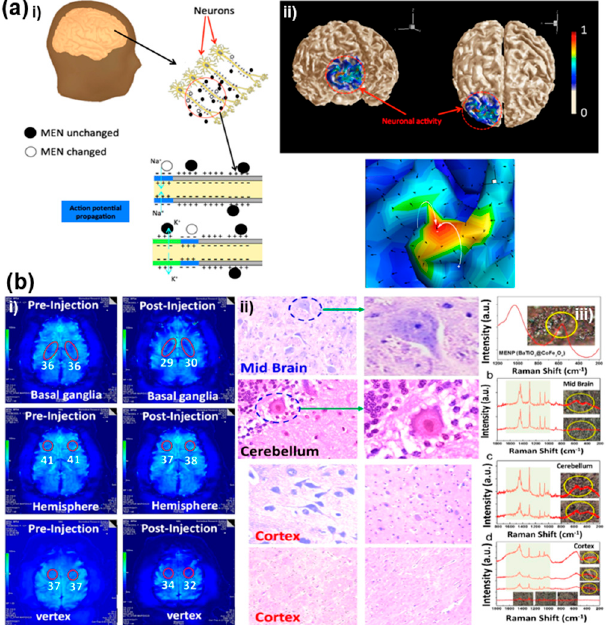
Figure 6. Brain mapping by detecting magnetic signals induced by MENPs located on the targeted brain or other tissues. ( a )-(i) Magnetic particle imaging (MPI) brain imaging applications enhanced with charge sensing based on the ME phenomenon of the MENPs. (ii) Visualized brain map computationally modeled by placing MENPs on the specific area of the brain. [50]. Copyright 2018, BMC Springer Nature. ( b )-(i) Scans of magnetic resonance images (MRI) using MENPs delivered to the targeted location of the brain. (ii) Verification of MENP delivery by comparing the morphological assessment of injected MENPs with the scanned position of the MENPs. (iii) Evaluation of MENPs in the organs using Raman spectroscopy. Reproduced with permission from [93]. Copyright 2019, American Chemical